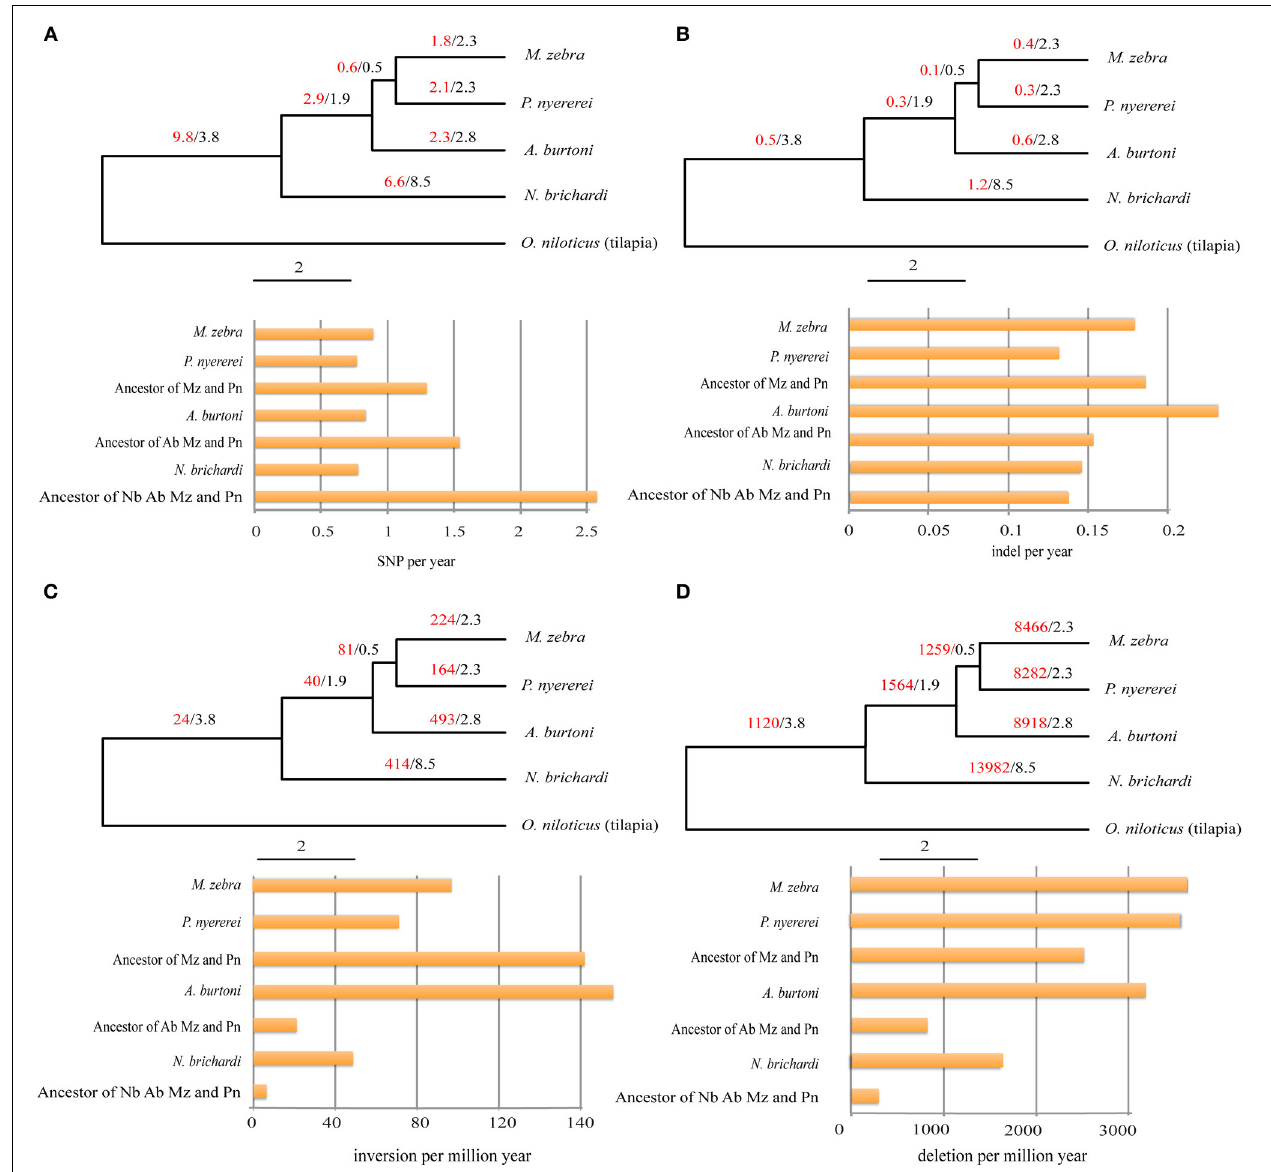
FIGURE 2 | The evolutionary patterns of SNPs, indels, inversions, and deletion during the adaptive radiation of African cichlids. The phylogeny was adopted from the cichlid genome paper (Brawand et al., submitted). The evolution of SNP, indel, inversion, and deletion were shown in (A–D) . The numbers before and after slash are the number of the lineage specific variation and the divergence time (million years). The